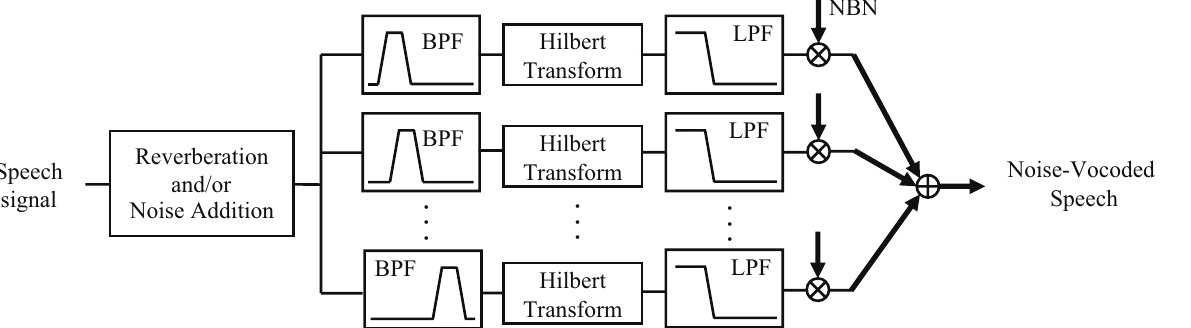
Figure 1. Schematic diagram of noise-vocoded method used for generating experiment stimuli (NBN: narrow band noise). BPFs were defined as ERB N -number from 3 to 35 Cam with bandwidths of 2ERB N . Number of channels was 16 [17].